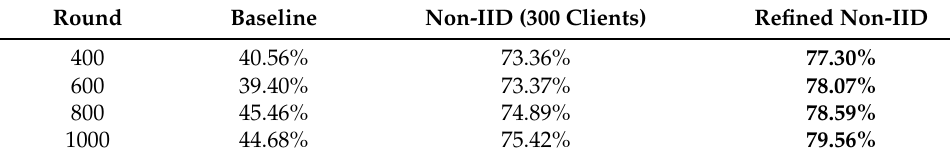
Table 9. Non-IID with refined Non-IID based on chest X-ray images.